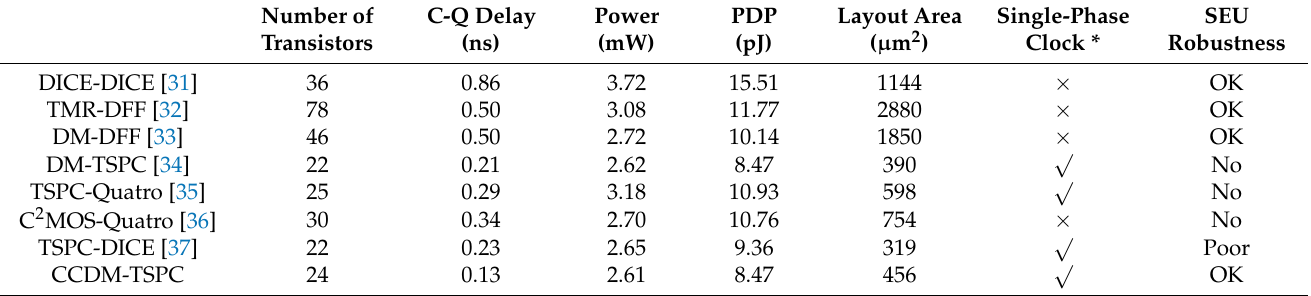
Table 1. Performance summary and comparison for radiation-hardened D flip-flops.